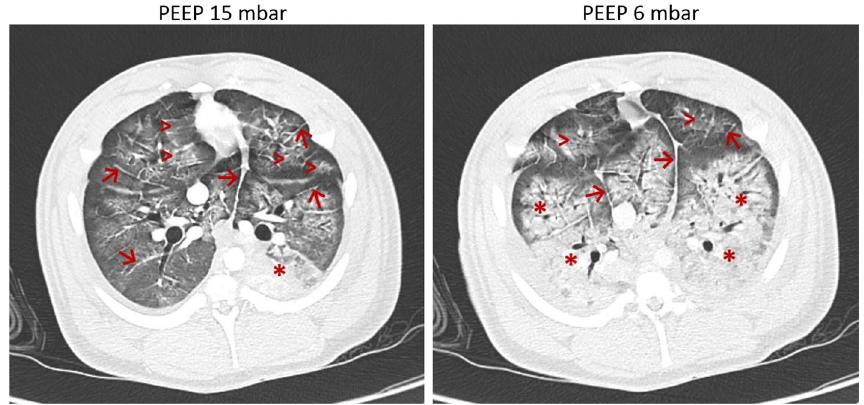
Fig. 7 Computed tomography. Representative computed tomography (CT) images of the basal lungs segments of a pig following lavage-induced surfactant depletion and 3 h of injurious ventilation. Images were taken during ventilation with PEEP of 15 vs. 6 mbar and a V T of 6 mL/kg body weight. Ground glass opacities ( >), interlobar and intralobular septal thickening ( ) are representative of the severity of lung → injury. Note the significant increase of atelectatic regions (*) as a sign of derecruitment in the dependent lung areas upon PEEP